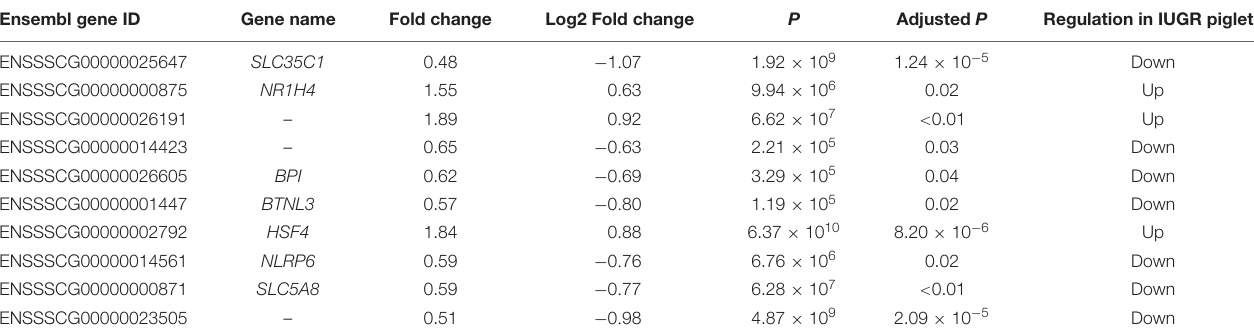
TABLE 2 | Differentially expressed genes of IUGR piglets in relative to NBW piglets with a fold change ≥ 1.5 and P ≤